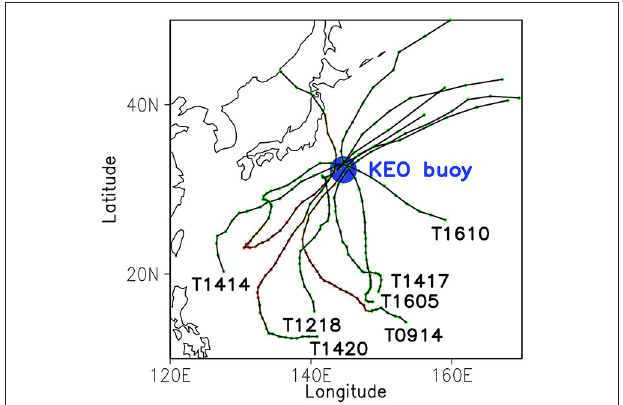
FIGURE 1 | Trajectories of seven tropical cyclones in the western North Pacific that have passed over or close to the KEO buoy location (blue dot). The seven tropical cyclones considered here are listed in Table 1 . The central pressures of these tropical cyclones at 6-h intervals along their trajectories is indicated by red, yellow, and green dots with the red-to-yellow transition set at 950 hPa and the yellow-to-green transition set at 970 hPa. Storm T1610 approached the KEO buoy twice: first from the east and then later from the southwest after performing an anticlockwise migration. The trajectory and central pressure data are obtained from the Japan Meteorological Agency.